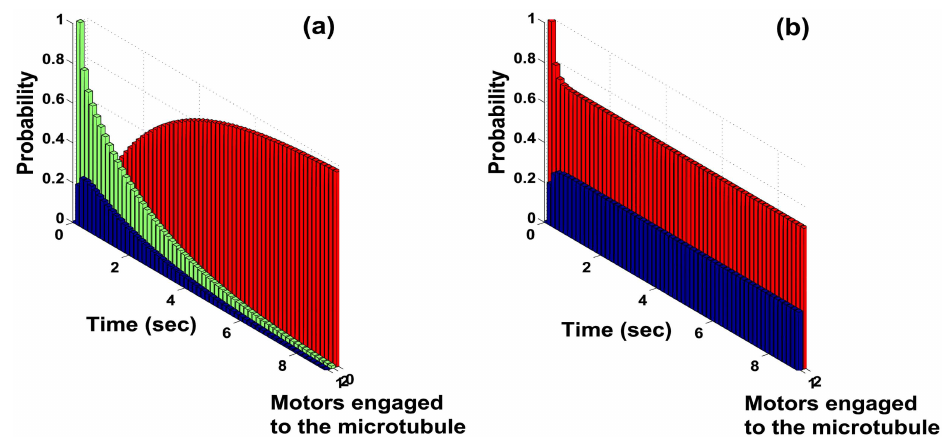
Fig 1. Probability of motors being bound to the microtubule at time t under load force of 1.2 pN for the WM case. In (a) the probabilityof one bound motor (blue) and two bound motors (green) approaches0 as time t ! 1 . Probability of no bound motors (red) (i.e. the cargo dissociatesfrom the microtubule) approaches 1 as t ! 1 . In (b) the probability of one bound motor (blue) and two bound motors (red) under the conditionthat cargo is not lost, reaches a steady